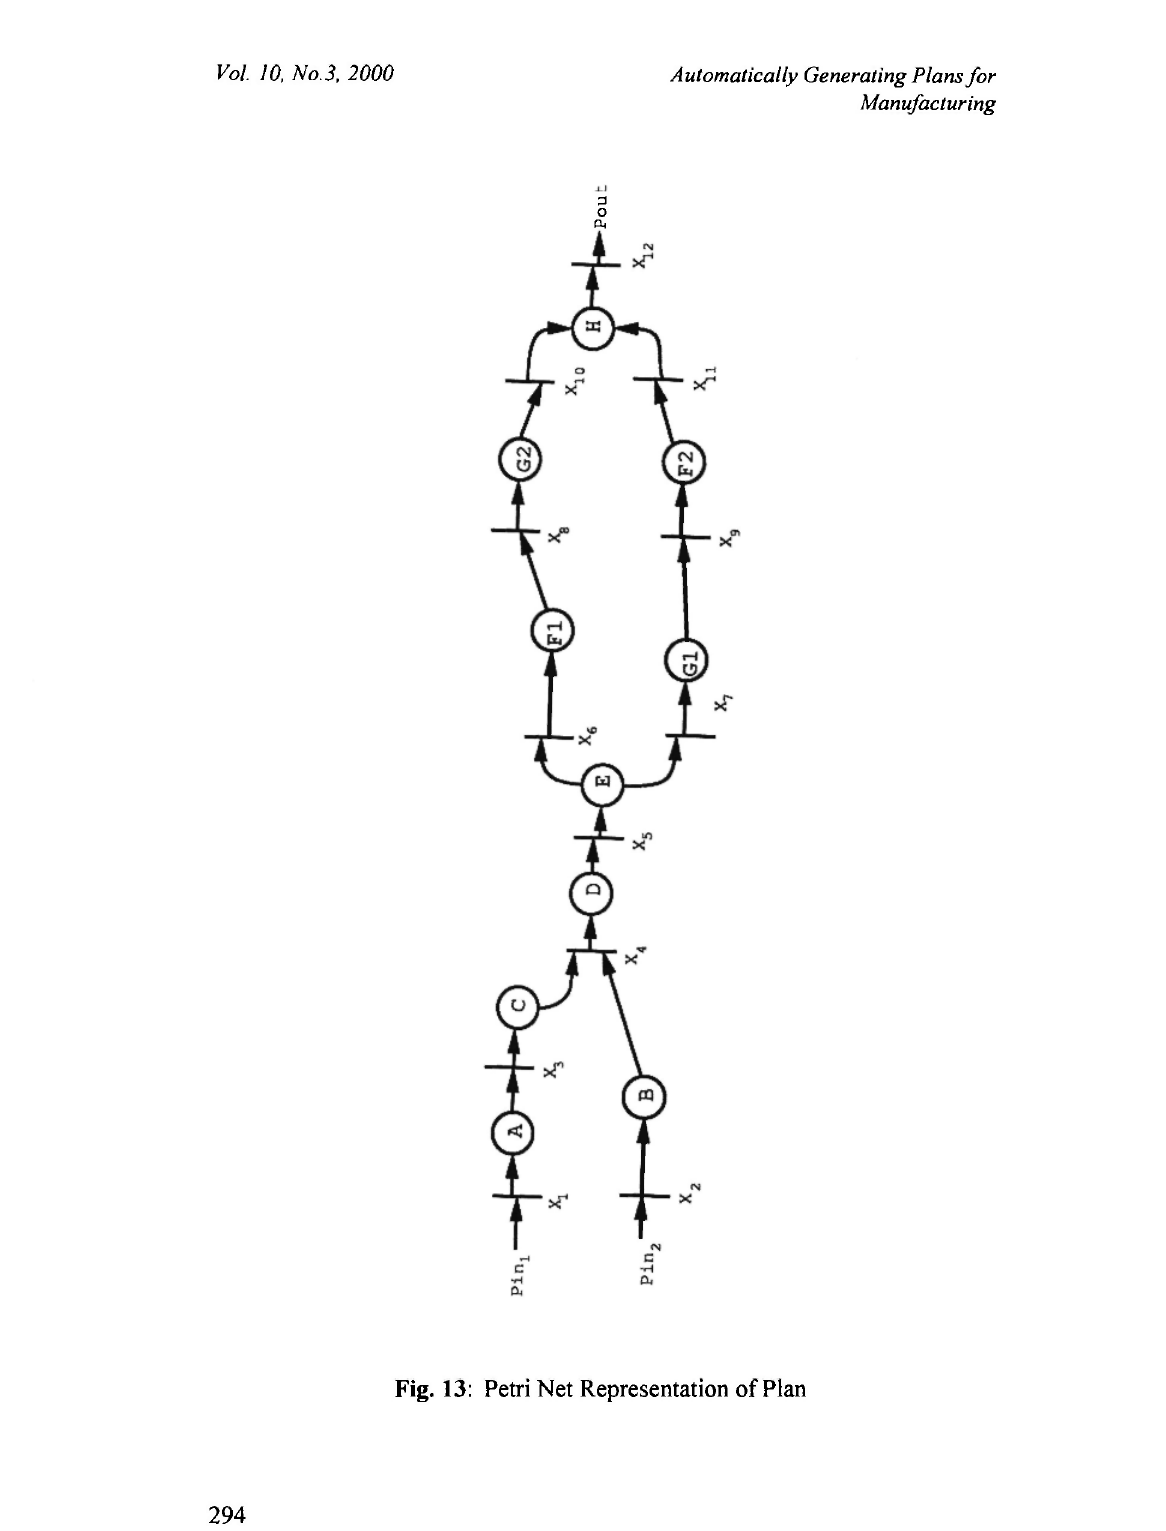
Fig. 13: Petri Net Representation of